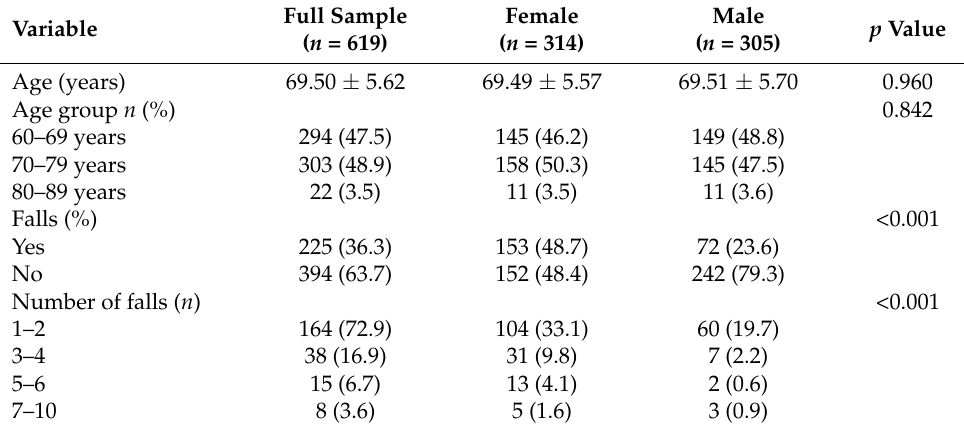
Table 1. Main characteristics of the sample.